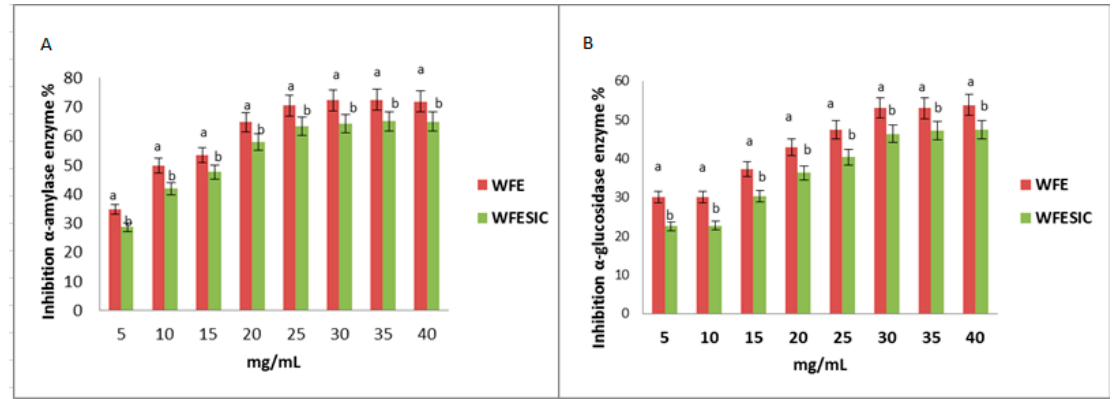
Figure 2 Effect of Inhibition against activity in xoconostle ( Opuntia sp ) for ( A ) α -amylase enzyme. ( B ) α -glucosidase enzyme. WFE: Whole Fruit Extract. WFESIC: Whole Fruit Extract simulated intestinal conditions. Values are mean of three replications ± standard deviation. Different lowercase letters in error bars indicate significant differences (p < 0.05) between the WFE and WFESIC in each concentration.